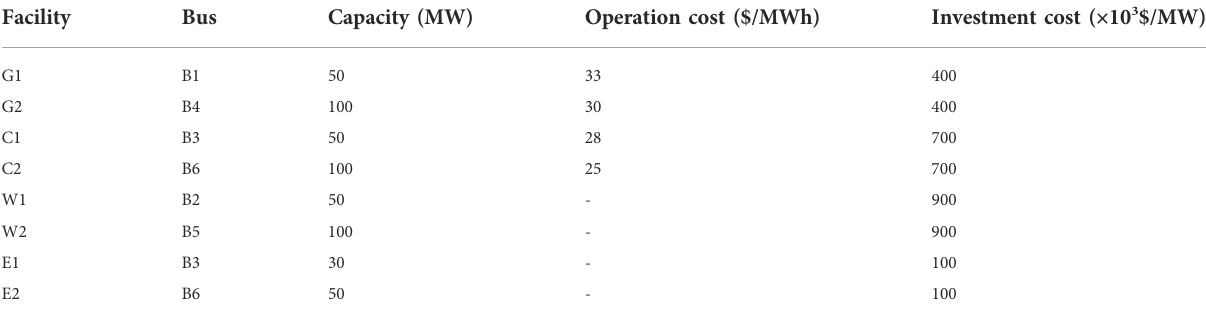
TABLE 1 Candidate facilities